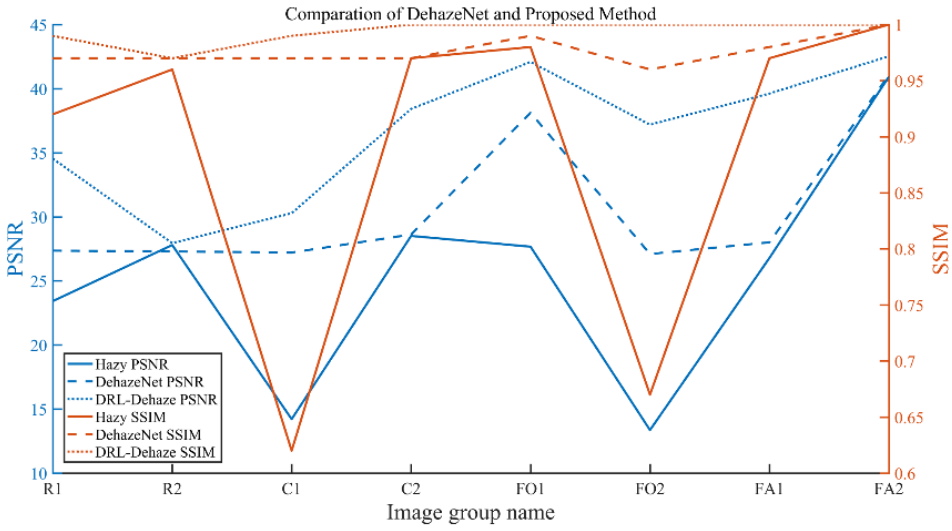
Figure 10. Comparation of DehazeNet and the DRL_Dehaze methods in various areas.